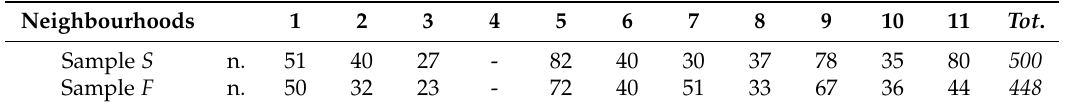
Table 3. Distribution of the samples of properties for sale and for rent by